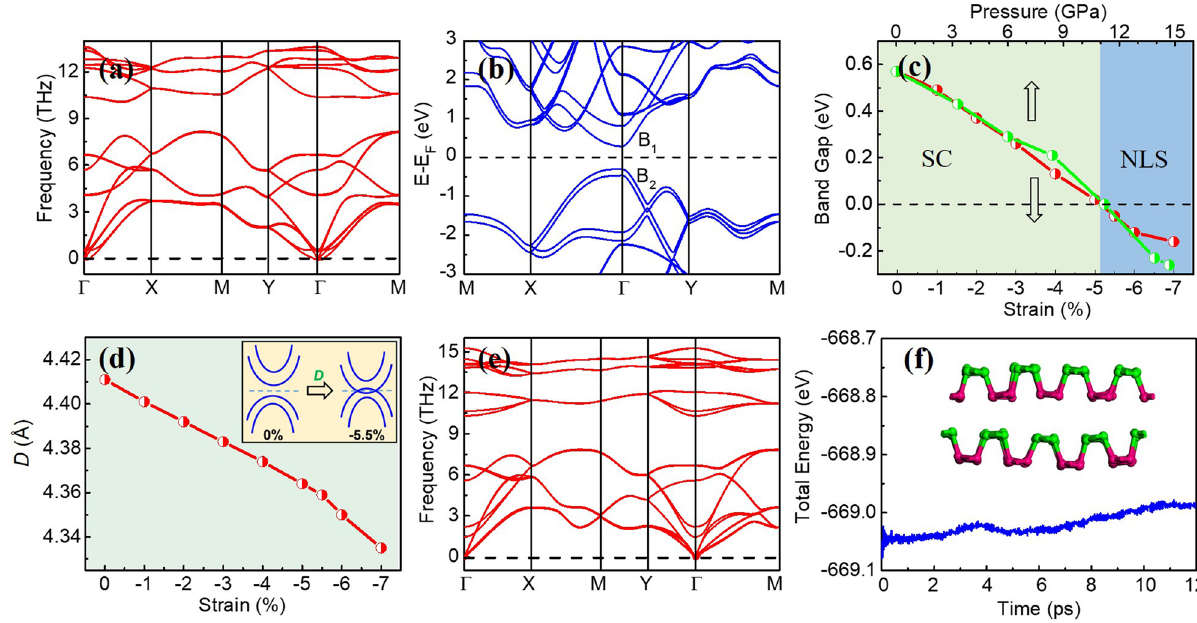
Figure 2. ( a ) Phonon spectrum of the pristine bilayer BP considered. ( b ) Band structure of the bilayer BP. The ‘B 1 ’ and ‘B 2 ’ indicate the two bands near to the E F . ( c ) Band gap as a function of the biaxial compressive strain (red points) and external pressure (green points) in the bilayer BP. ( d ) The interlayer distance ( D ) as a function of the biaxial compressive strain in the bilayer BP. The inset shows the evolution of the bands around the E F , primarily composed of the p z orbitals, without and with the biaxial strain. The dash lines in the inset give the E F . ( e ) Phonon spectrum of the bilayer BP under a 5.5% compressive strain. ( f ) Total energy fluctuation of the bilayer BP under a 5.5% compressive strain during the MD simulation at 300 K. The inset in ( f ) shows the atomic structure of the bilayer BP at the end of the MD